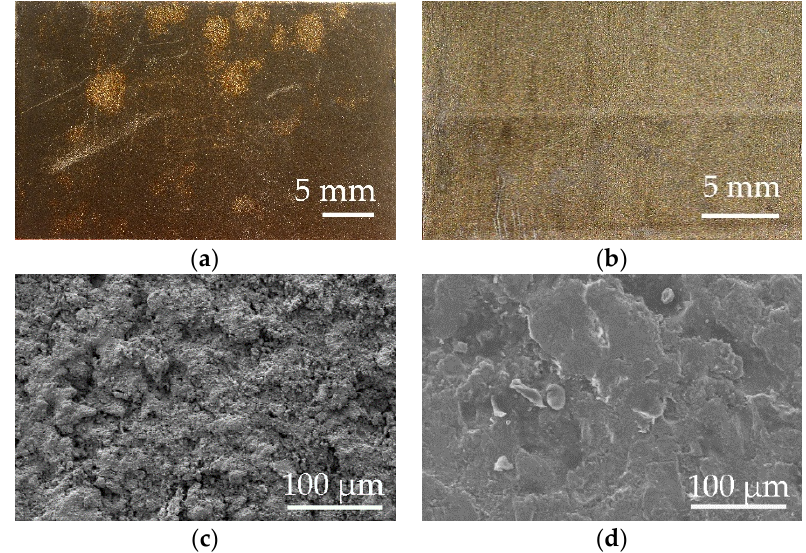
Figure 6 . Photography obtained by digital camera and micrography obtained with SEM of the surface appearance of the EN-AW5754 substrate after laser stripping. ( a ) Digital camera SPI laser-CW and ( b ) digital camera Quanta Q-switch, ( c ) SEM SPI laser-CW, ( d ) SEM Quanta-Q-switch.